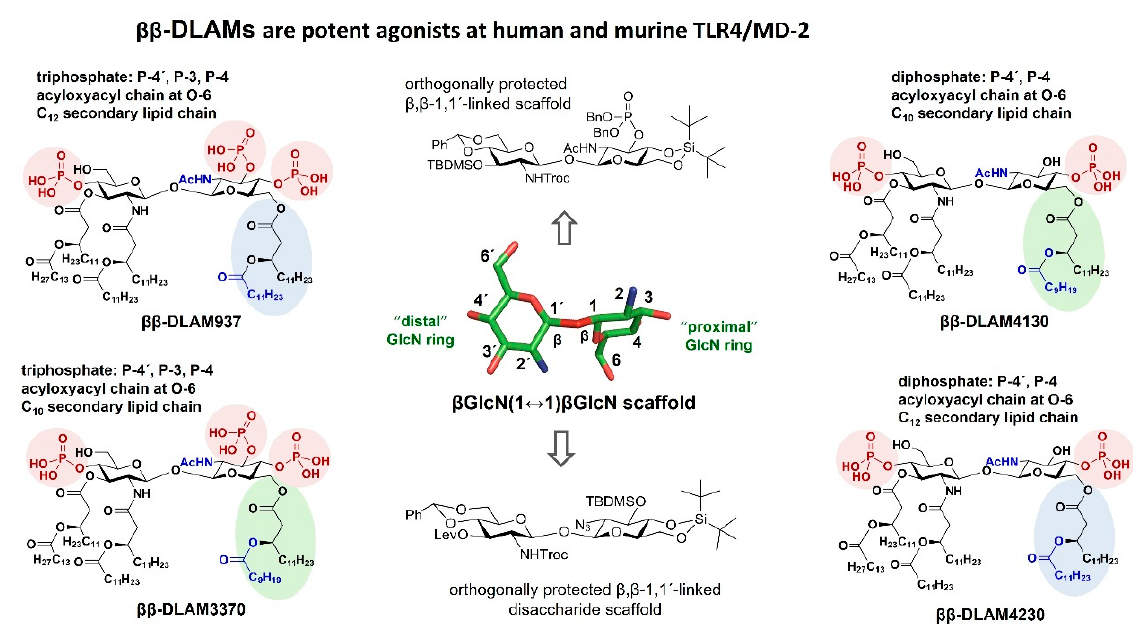
Figure 9. Potent disaccharide-based TLR4 agonists derived from a β GlcN(1 ↔ 1) β GlcN scaffold ( ββ - DLAMs).